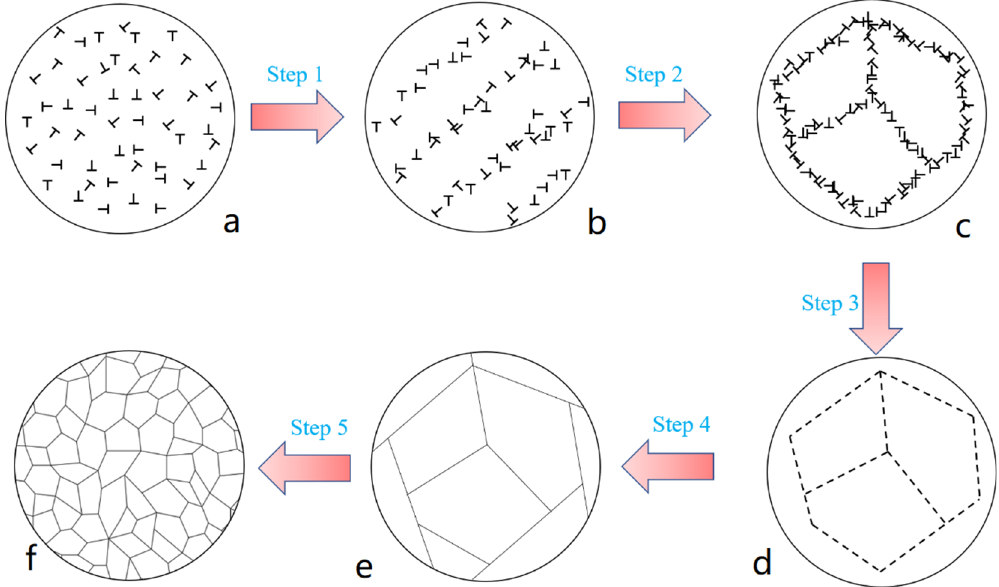
Figure 7. Schematic diagram of grain refinement processes of the Al7075 induced by